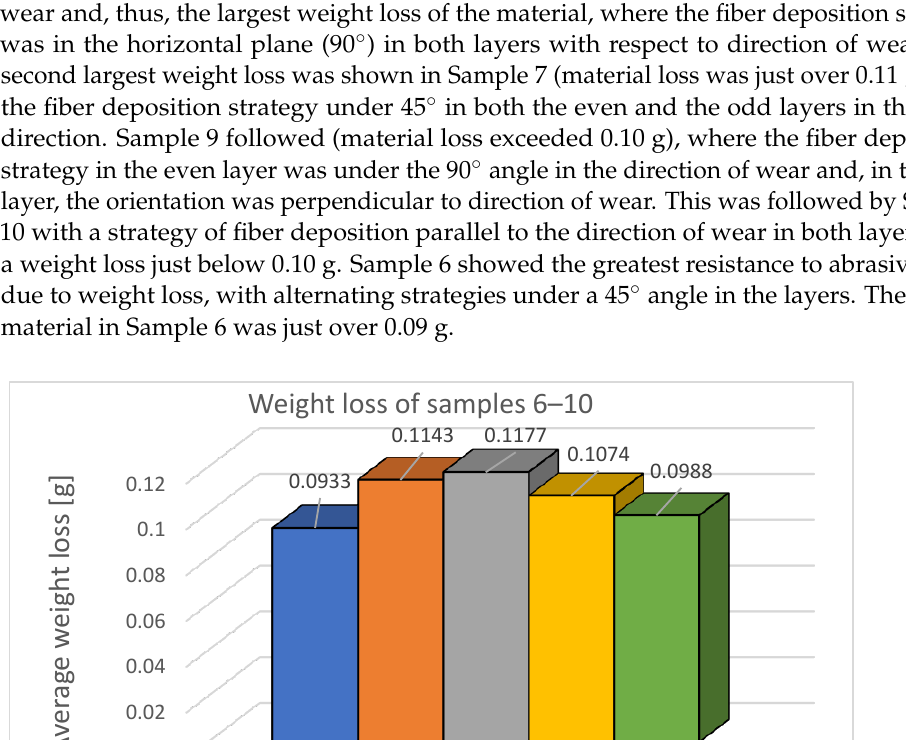
Table 9. Weight differences in samples 6–11